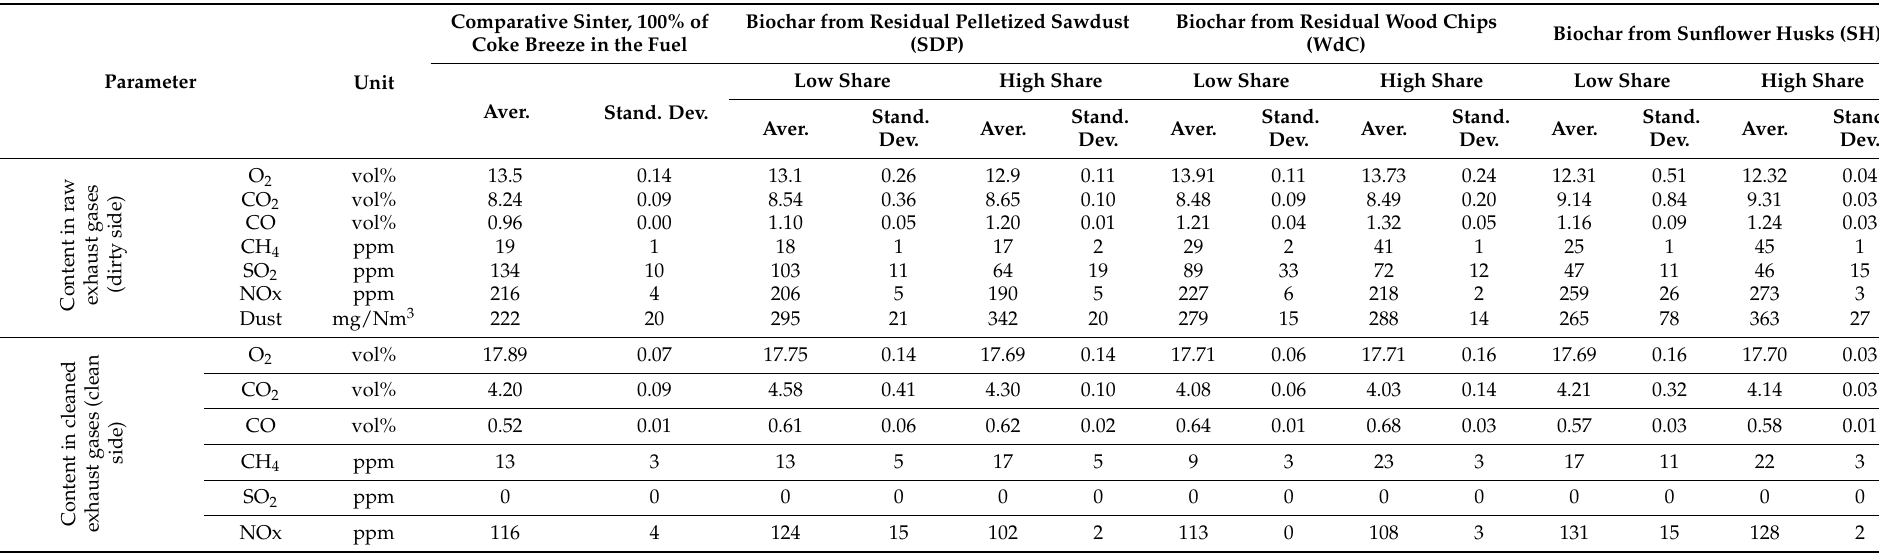
Table A2. Detail results of composition of exhaust gas on the dirty side (before catalytic ceramic filter) and on the clean side (in the emitter) obtained for fuel mixtures with biochar and coke breeze